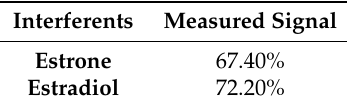
Table 9. Study of the selectivity of the proposed sensor to the possible interferents present in water samples.